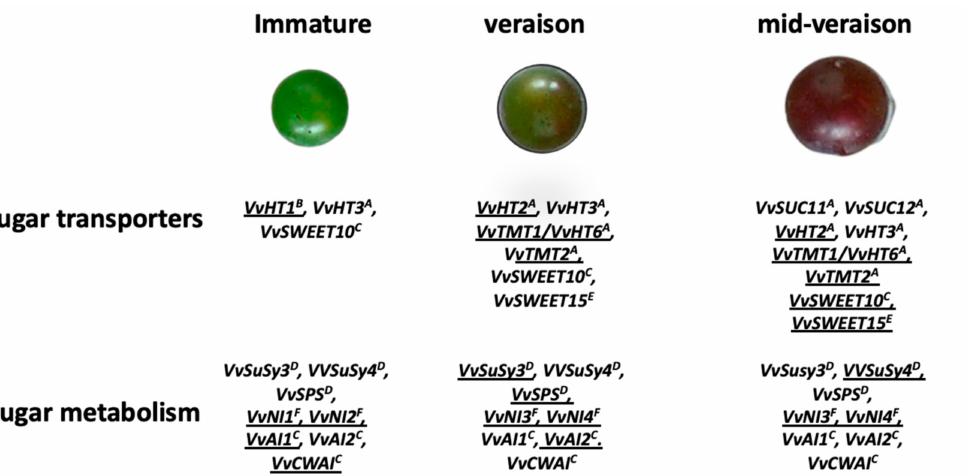
Figure 1. Schematic representation of transcript abundance of sugar metabolism enzymes and sugar transporters in the pericarp of Vitis vinifera during development. Underlined genes are the ones whose transcripts are most abundant at the given stage of development. Letters correspond to the following references: (A) [74]; (B) [75]; (C) [76]; (D) [77]; (E) [78]; (F) [79]. Additional gene information is given in Supplementary Table S1. Abbreviations: AI = acid invertase; CWAI = cell wall acid invertase; HT = hexoses transporters; NI = neutral invertase; SWEET = sucrose will eventually be exported transporter; TMT = tonoplast monosaccharide transporter; SuSy = sucrose synthase; SPS = sucrose phosphate synthase. Ripening stages (veraison, mid-veraison and ripe) are those defined by Coombe [80] and Fasoli et al.